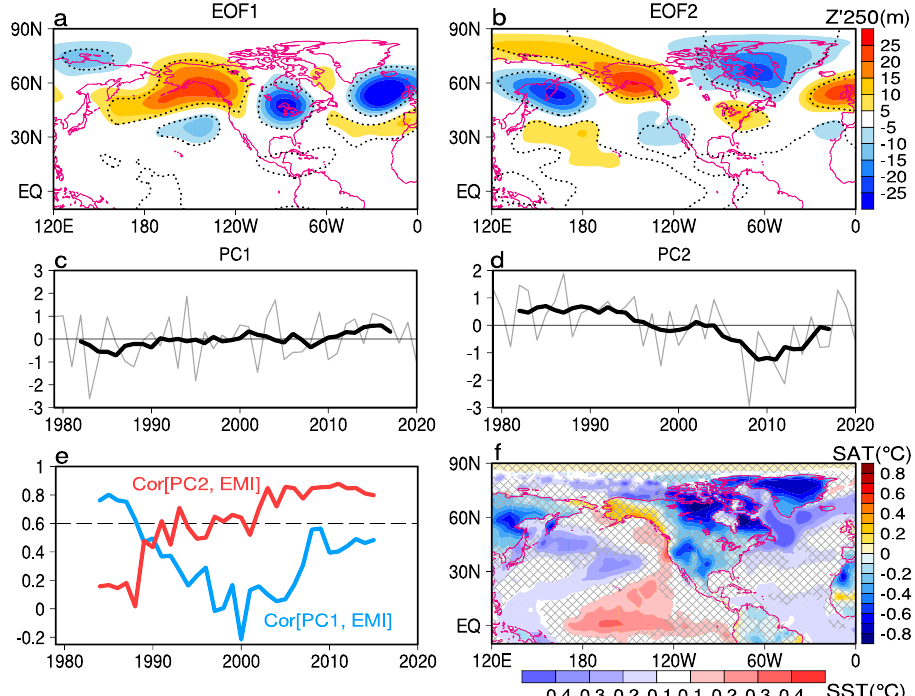
Fig. 2 Major modes of summer tropospheric circulation over Paci fi c and Atlantic sectors. Regressed anomalies of eddy component of 250-hPa geopotential height onto ( a ) fi rst and ( b ) second empirical orthogonal function (EOF) modes, and ( c ), ( d ) corresponding principal components (PCs) for 1979 – 2020, respectively. Dotted contours in ( a ), ( b ) indicate the 95% signi fi cant level, and thick black lines in ( c ), ( d ) indicate 7-year running means. e 11- year running correlations between El Niño Modoki index (EMI) and PC-1 (blue line) and between EMI and PC-2 (red line). Dashed line denotes the 95% signi fi cant level. ( f ) Regressed anomalies of surface air temperature (SAT) over land or ice and sea surface temperature (SST) over open water onto PC-2. Hatching denotes that the anomalies are not statistically signi fi cant at the 95% con fi dence level. COMMUNICATIONS EARTH & ENVIRONMENT| (2021) 2:257